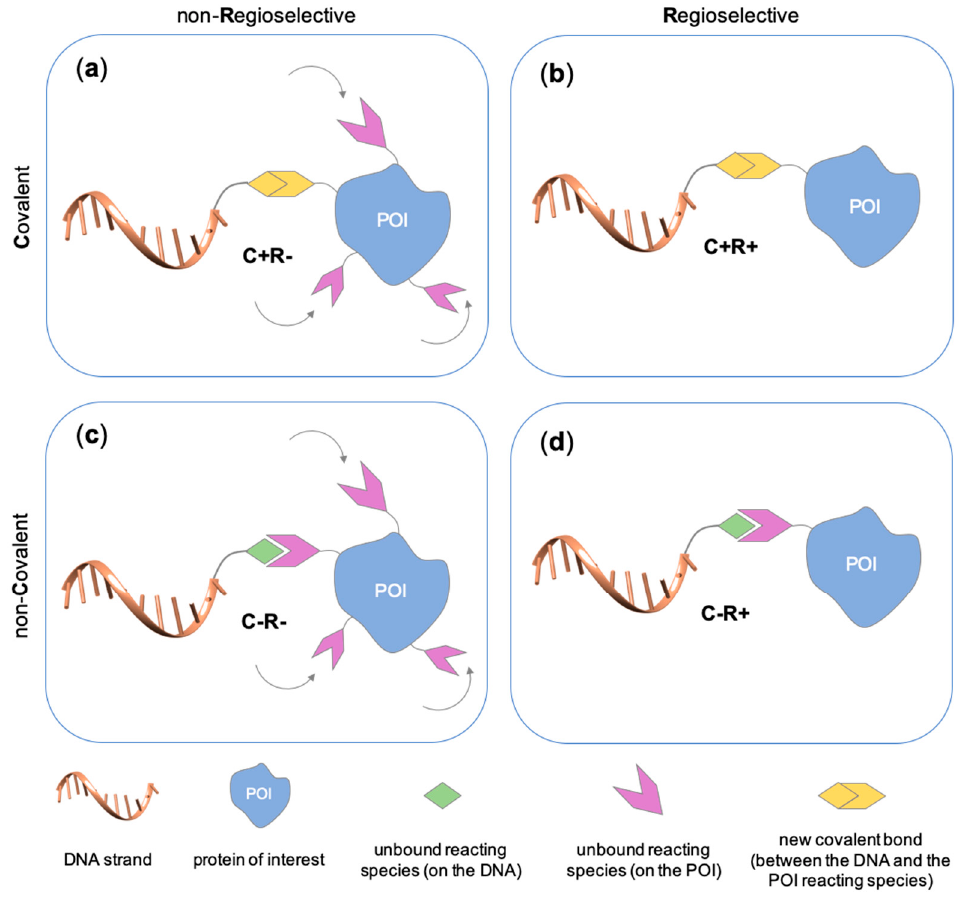
Figure 2. Schematic representation of the chemical methods typically adopted for the synthesis of DNA-protein conjugates. The strategies can be classified according to the establishment of a covalent (C+) or non-covalent (C-) bond between the DNA and protein component as well as on the occurrence (R+) or absence (R-) of regioselectivity. Accordingly, four classes can be distinguished: from ( a ) to ( d ), C+R-, C+R+, C-R- and C-R+. The establishment of a covalent bond between the DNA handle (green symbol) and the chemical moiety (magenta symbol) attached to the protein of interest (POI, in blue) gives rise to a new chemical group between the two molecules (yellow symbols merged together). A non-covalent bond instead preserves the identity of the interacting units (green and magenta symbols for the DNA and the POI handles, respectively).